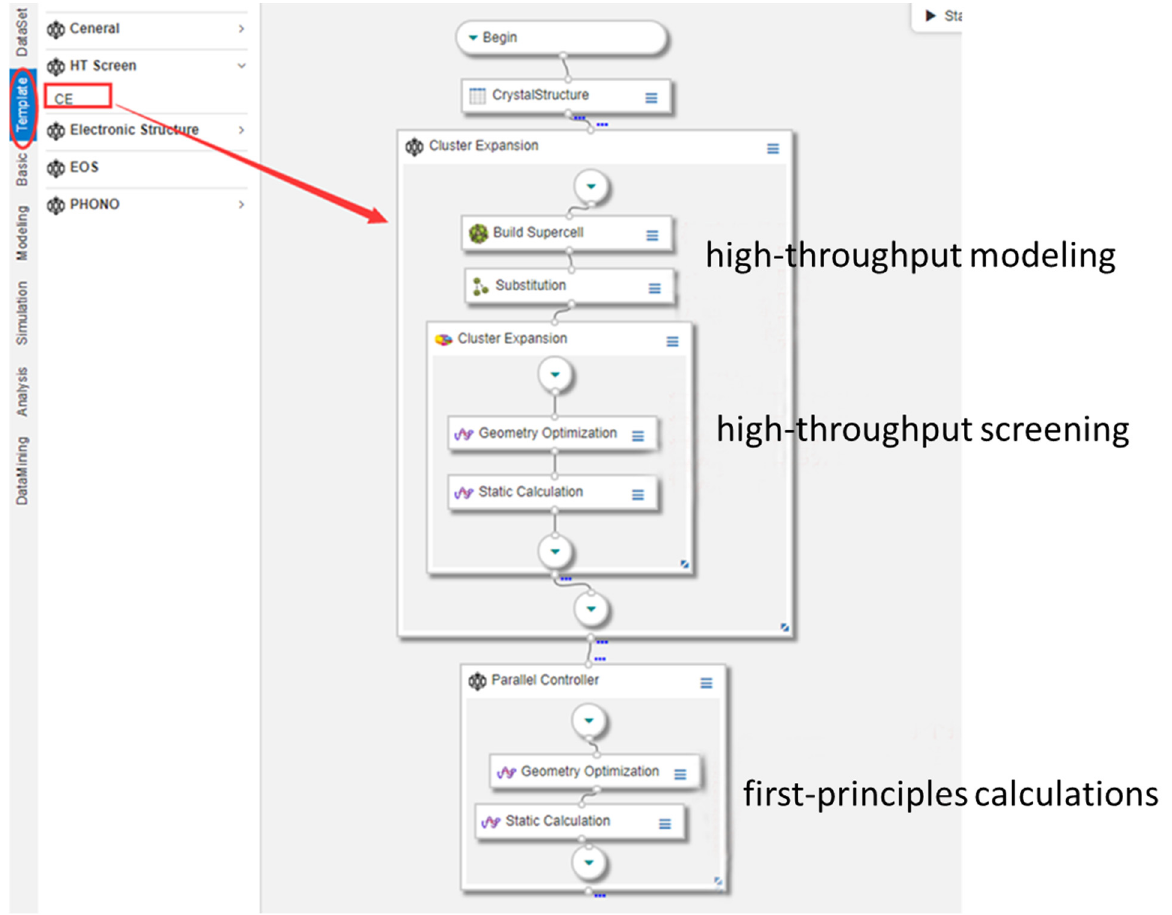
Figure 1. Calculation process for structure screening on MatCloud platform.